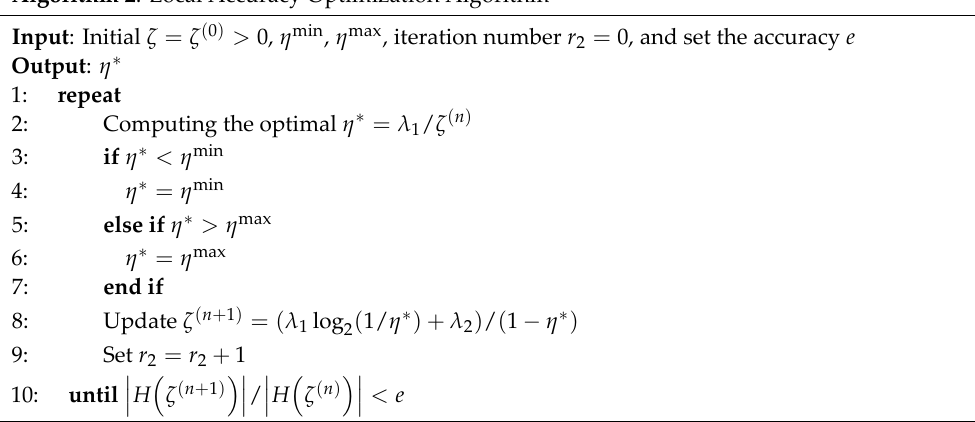
Algorithm 2 : Local Accuracy Optimization